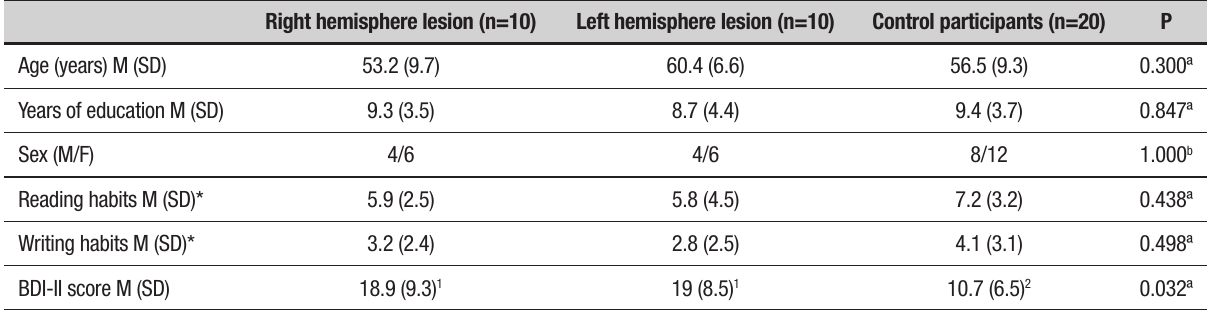
Table 1. Sociodemographic and clinical characteristics of patients and control participants (n=40).